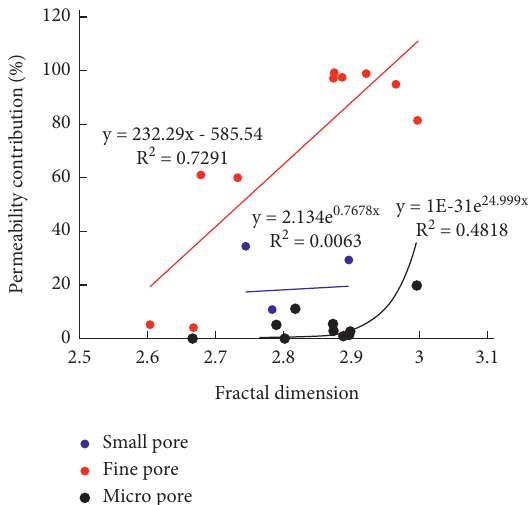
Figure 4: The relationship between permeability contribution and fractal dimension of different pores.